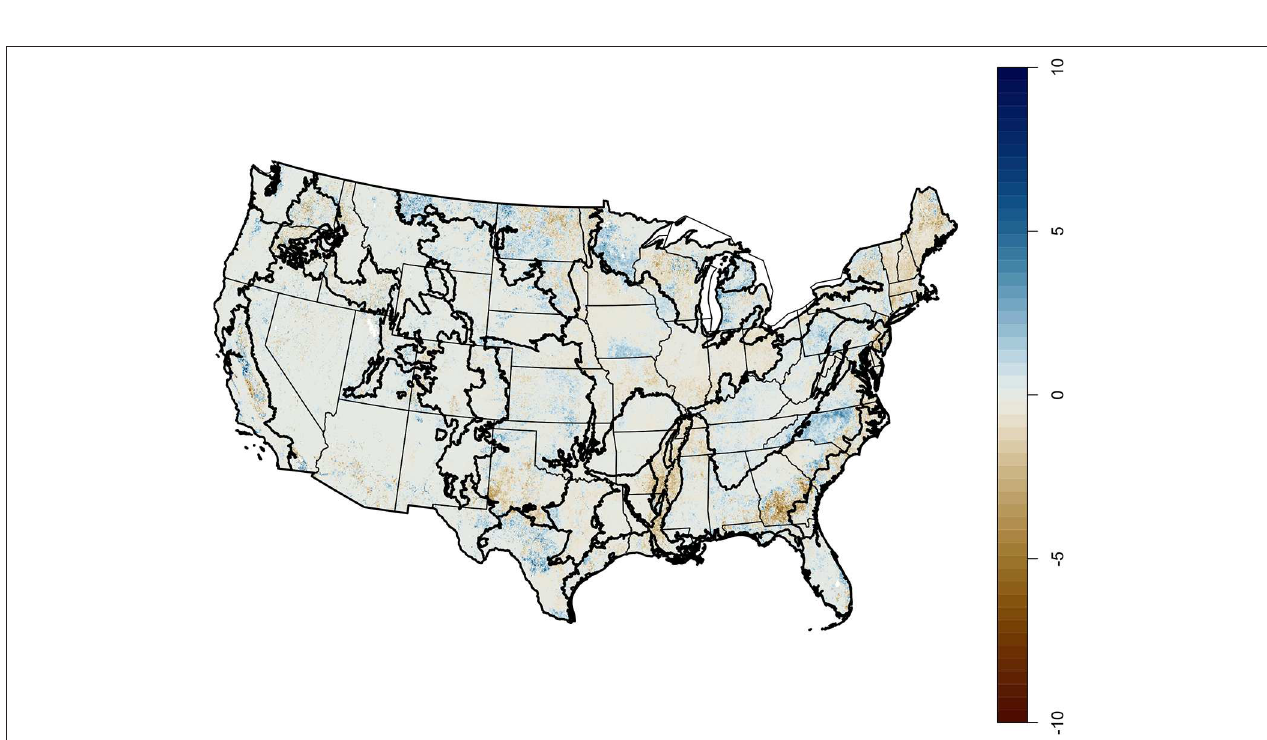
FIGURE 4 | Change in annual crop effective richness, 2008–2018.